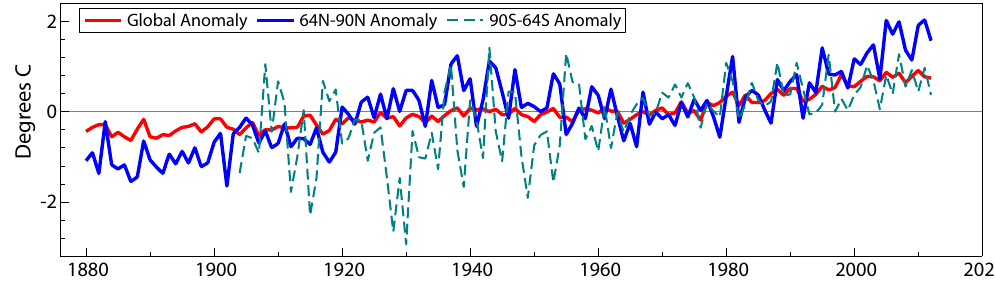
Fig. 4. Temperature anomalies relative to 1951–1980